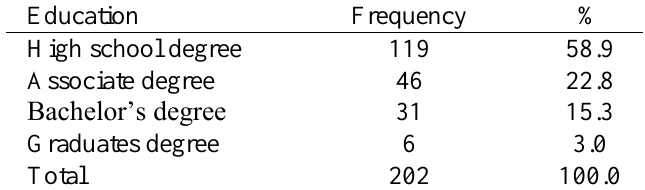
Table 4. Distribution of participants by educational status